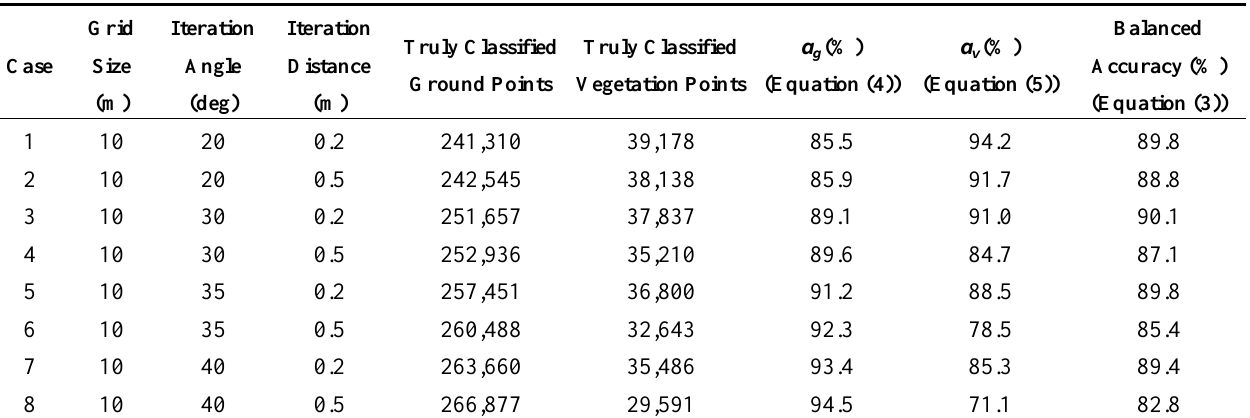
Table 2. Ground classification results of BoMMS data. The reference points include 282,373 manually classified ground points and 41,593 vegetation